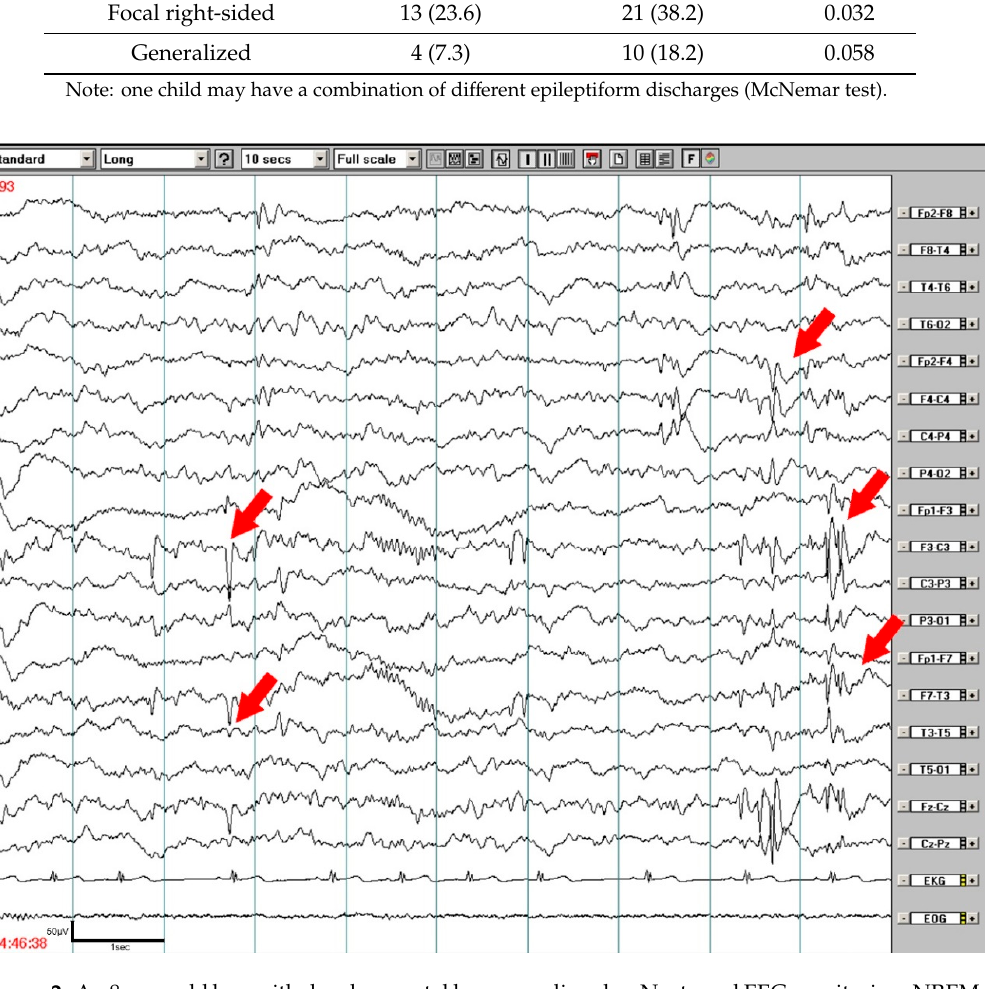
Figure 2. An 8-year-old boy with developmental language disorder. Nocturnal EEG monitoring–NREM (non-rapid eye movement) sleep, stage 2. Focal epileptiform discharges predominated in the left fronto-temporo-central areas.